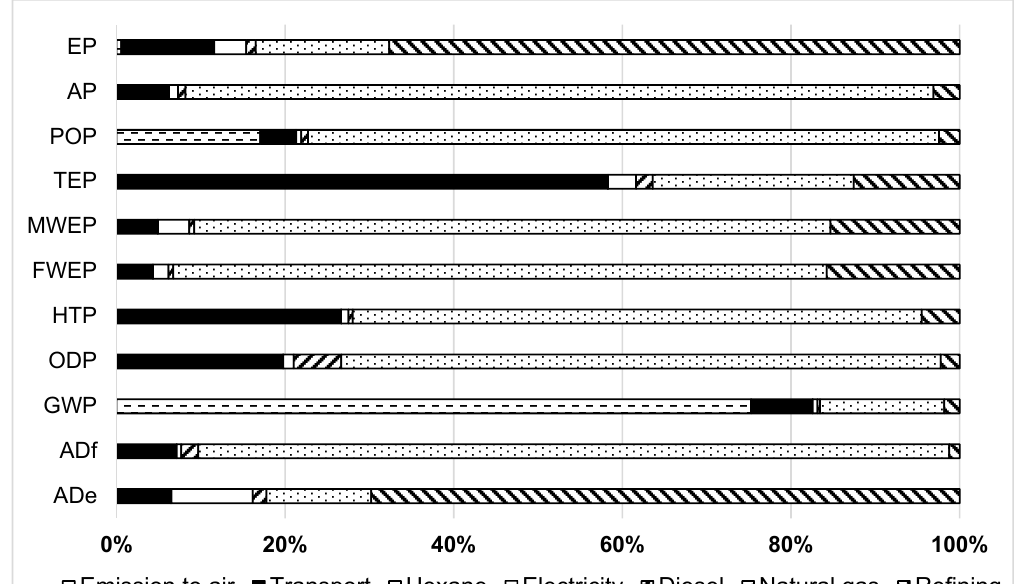
Figure 3. Percentage contribution to the impacts for anaerobic digestion scheme (AD): ( a ) positive contribution; ( b ) credits.